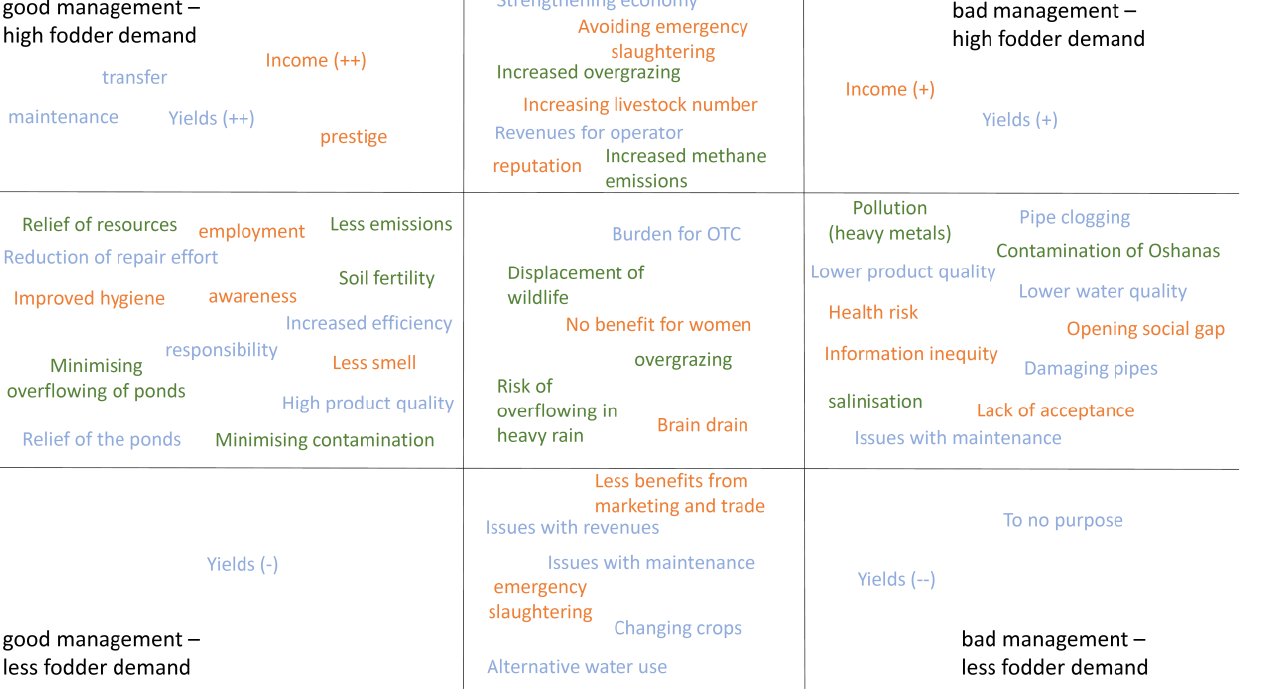
Figure 5. Ecological (green), social (orange) and economic impacts (blue) of the upgrading process associated with the four identified scenarios; corner fields represent impacts that occur only for the specific scenario; middle outer fields symbolise overlaps between two adjacent scenarios with the same driving force, and the field at the centre overlaps of all four scenarios.